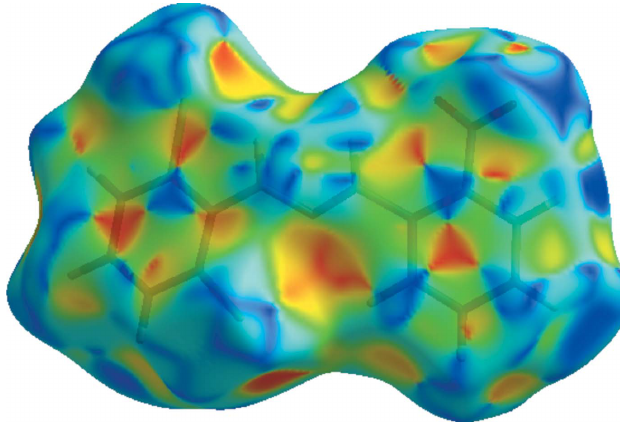
Figure 7 View of the three-dimensional Hirshfeld surface of the title compound plotted over